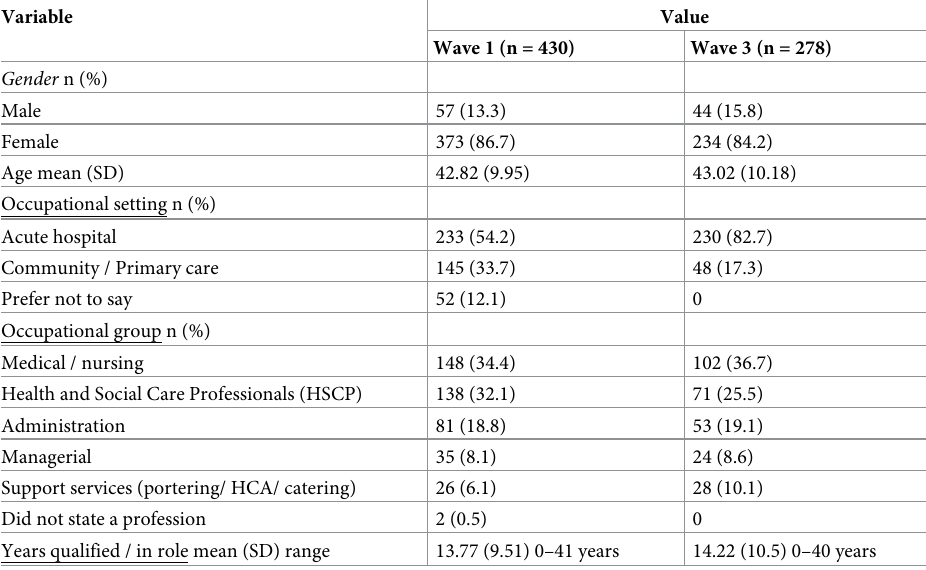
Table 2. Demographic and occupational variables of the